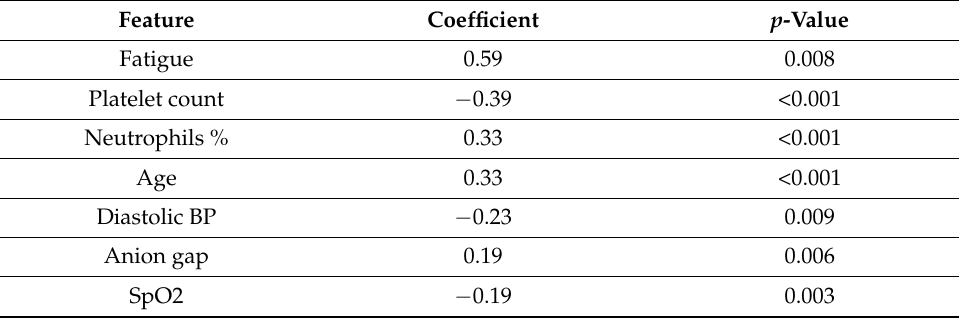
Table A4. Multivariate coefficients and p -values for Comparison 2 (ED